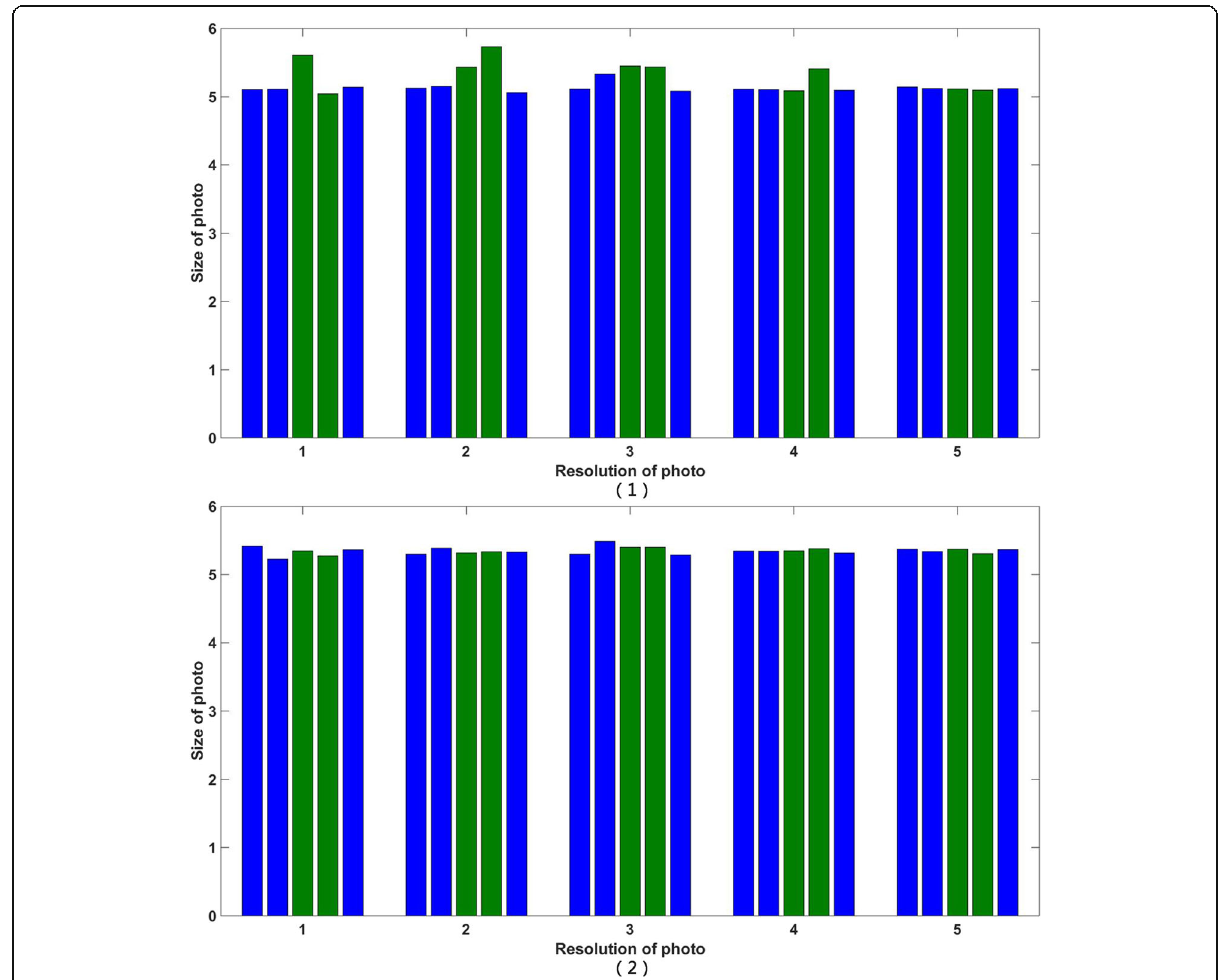
Fig. 5 The effect of resolution and size on entropy